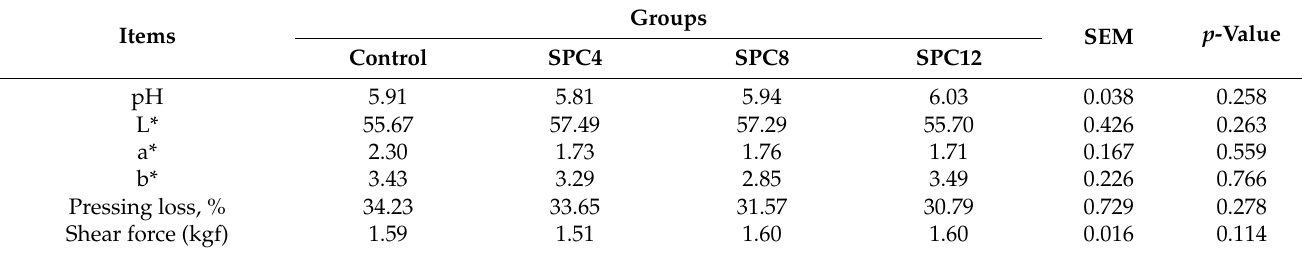
Table 8. Effects of dietary SPC in starter diet on meat quality of broilers at 42